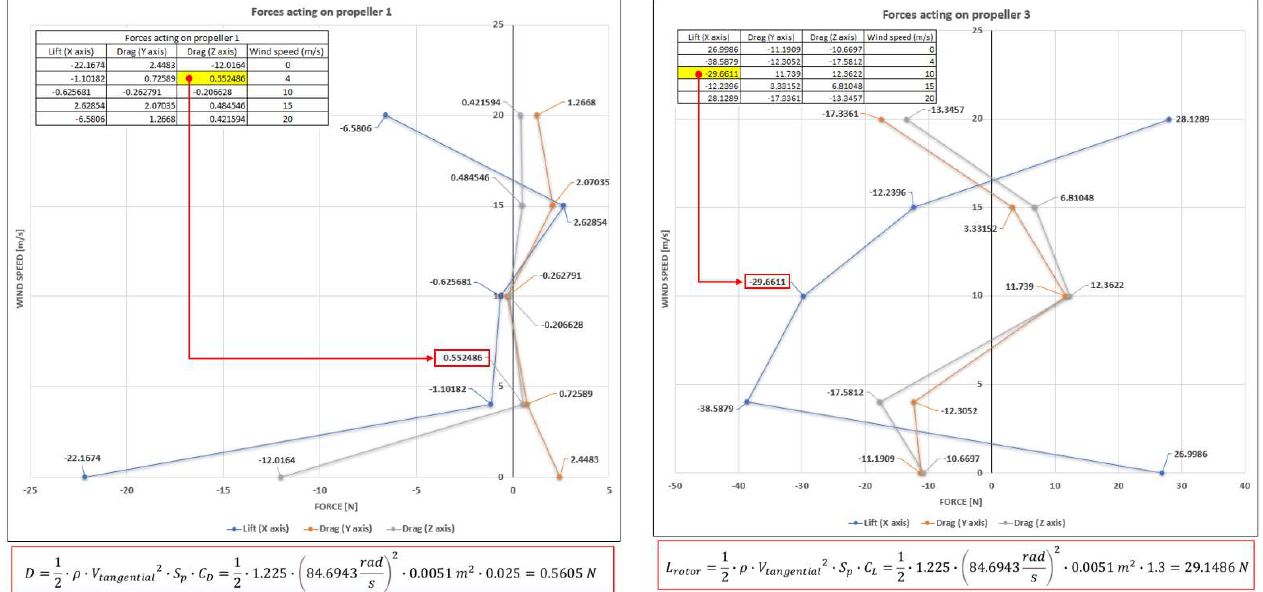
Figure 37. Streamlines and pressure contours on the rotors.